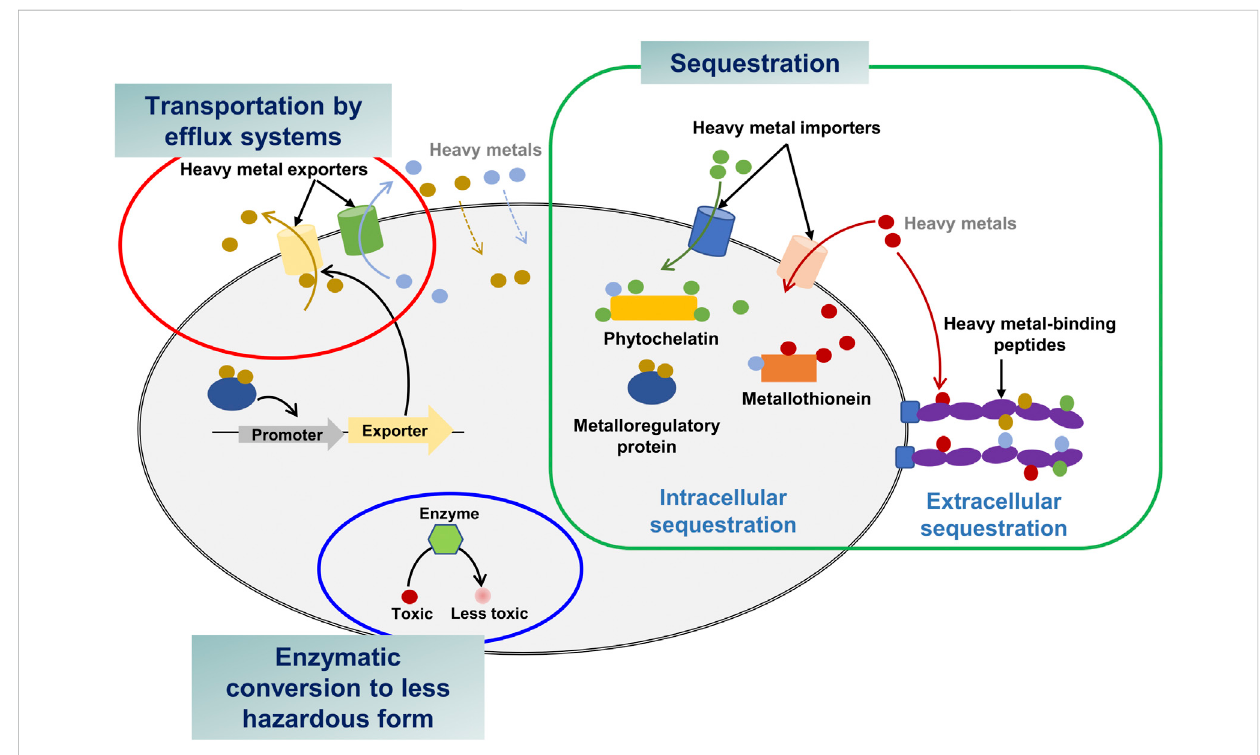
FIGURE 1 Heavy metal bioremediation mechanisms in bacteria.